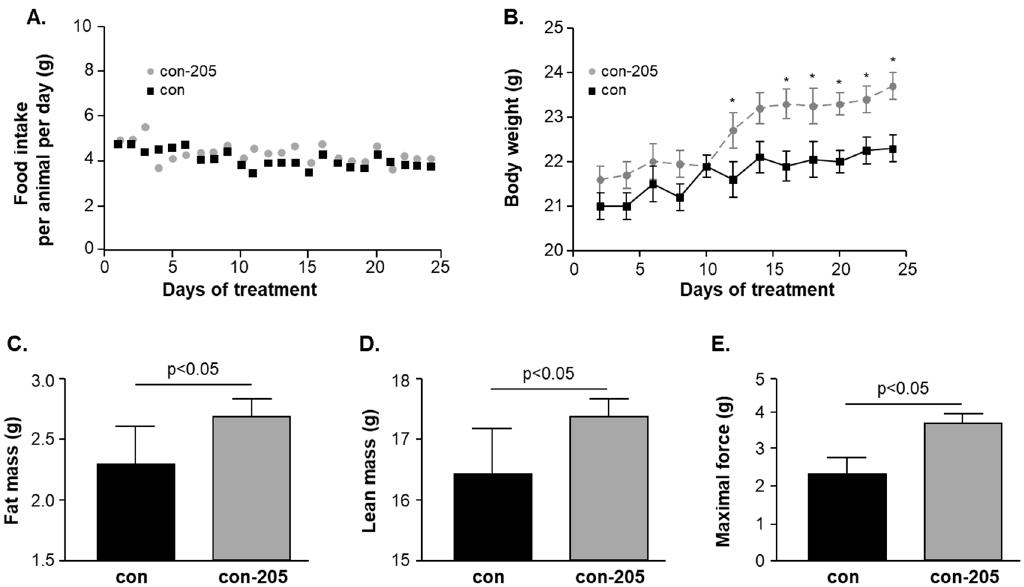
Figure 6. Effects of 24-day Myomed-205 feeding on healthy control mice. Supplementation of food with 1g Myomed-205 per kg standard diet did not affect food intake over 24 days ( A ). The Myomed-205 fed mice (con-205) had further elevated body weight (~6%) at day 24 when compared to control mice (con). Note that significant differences emerged at day 10 ( B ). Myomed-205 feeding increased total body fat by approximately 17% ( C ), total lean mass by 6% ( D ) and maximum muscle force by 50% ( E ) at day 24. Values are shown as mean ± standard error of the mean, * p < 0.05 vs. con.